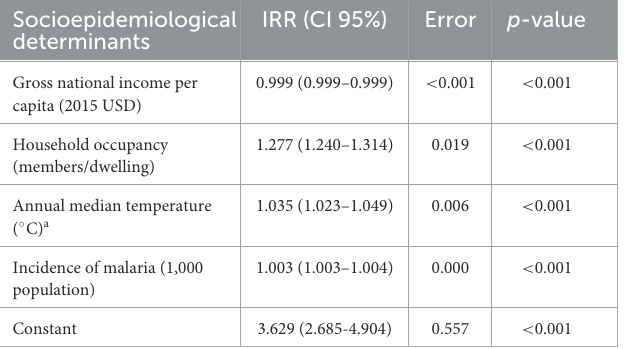
TABLE 2 Multivariate Poisson model for the incidence of BM in the world. Socioepidemiological